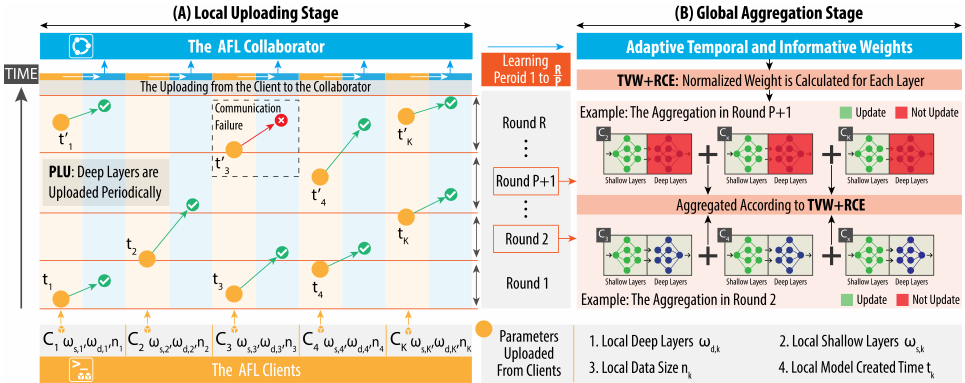
Figure 1. The two-stage asynchronous learning procedure and the allocation of the three adaptive strategies of Fed2A. ( A ) Local Uploading Stage to train and upload local models according to PLU, and ( B ) Global Aggregation Stage to aggregate received local models according to TVW and